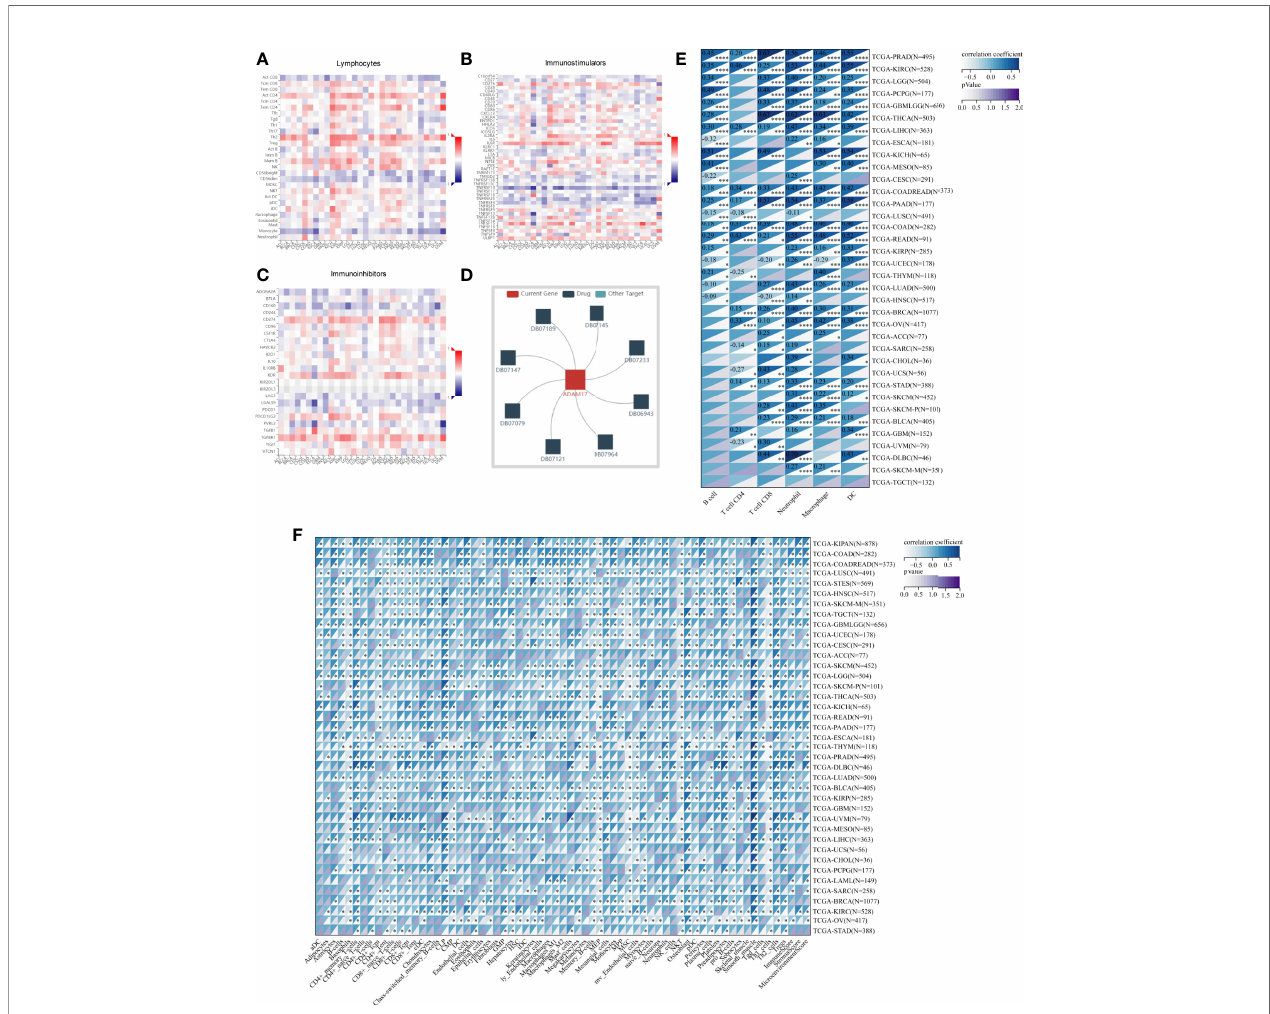
FIGURE 7 | Spearman correlations of the ADAM17 expression with tumor-immune systems in multiple cancer types and targeted drugs. (A) Lymphocytes. (B) Immunostimulators. (C) Immunoinhibitors. (D) targeted drugs. (E) Correlation between ADAM17 and 6 tumor-related immune cells calculated with TIMER. (F) Correlation between ADAM17 and 64 tumor-related immune cells and three Immune cell in fi ltration scores calculated with the deconvo xCell algorithm. * P < 0.05; ** P < 0.005; *** P < 0.001; **** P <